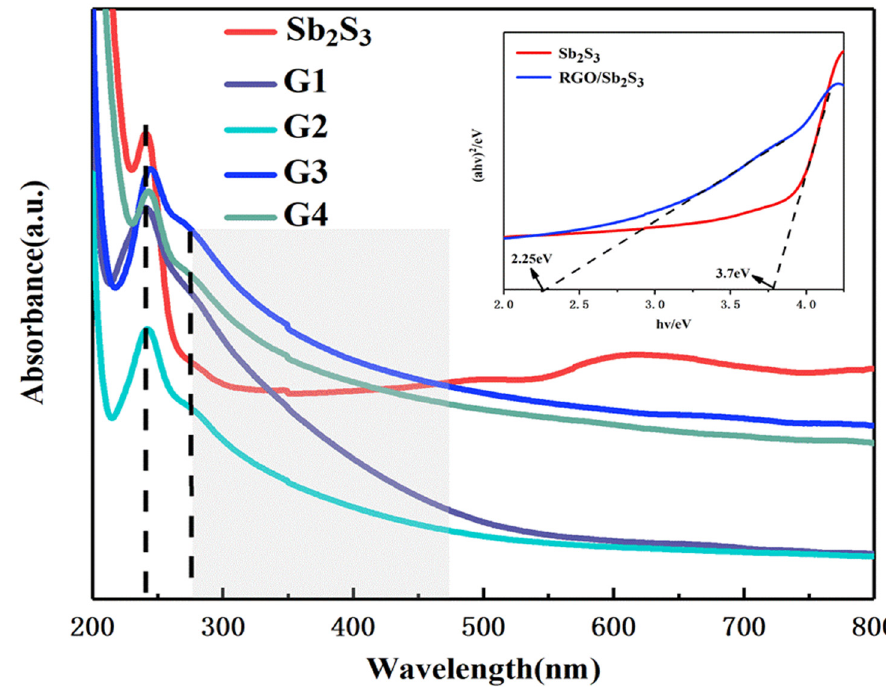
Figure 6. UV–Vis absorption spectra of Sb 2 S 3 and the Sb 2 S 3 /RGO composites.